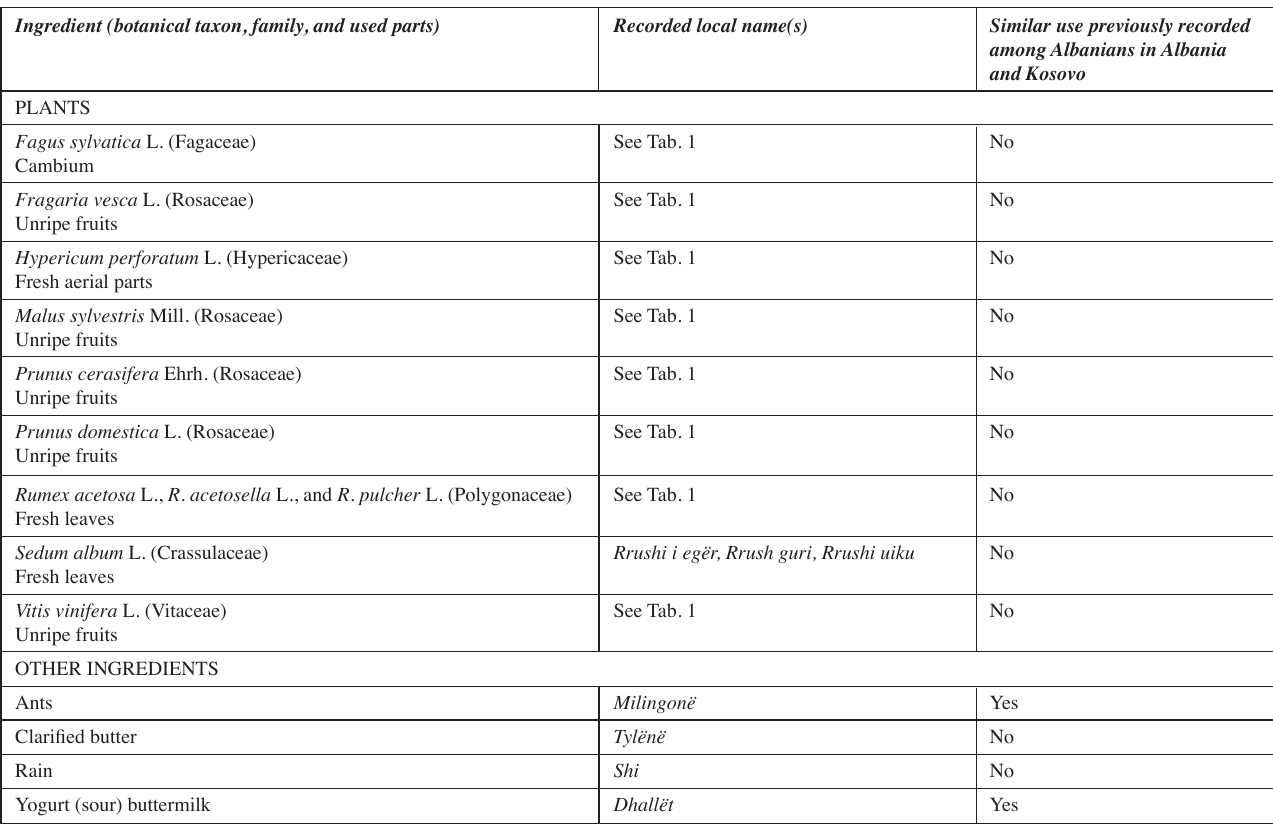
Tab. 2: Traditional, domestic yogurt starters mentioned and used in the study area in the past Ingredient (botanical taxon, family, and used parts)